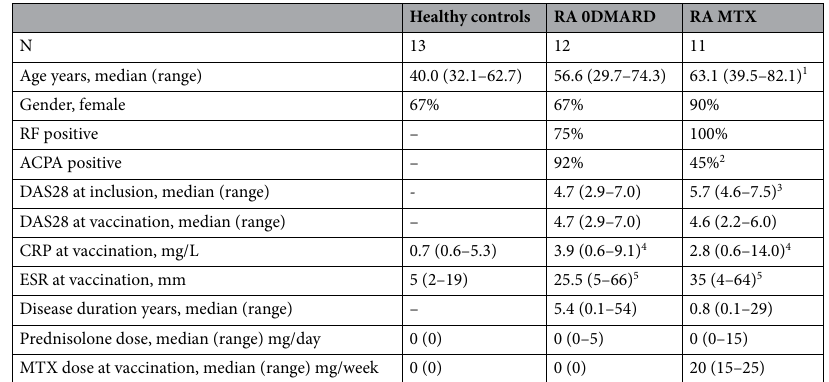
Table 1. Demographic, clinical and laboratory characteristics and treatment. 1 RA with MTX-start group were older than controls ( p = 0.002). 2 Percentage of ACPA positives were lower in RA with MTX-start